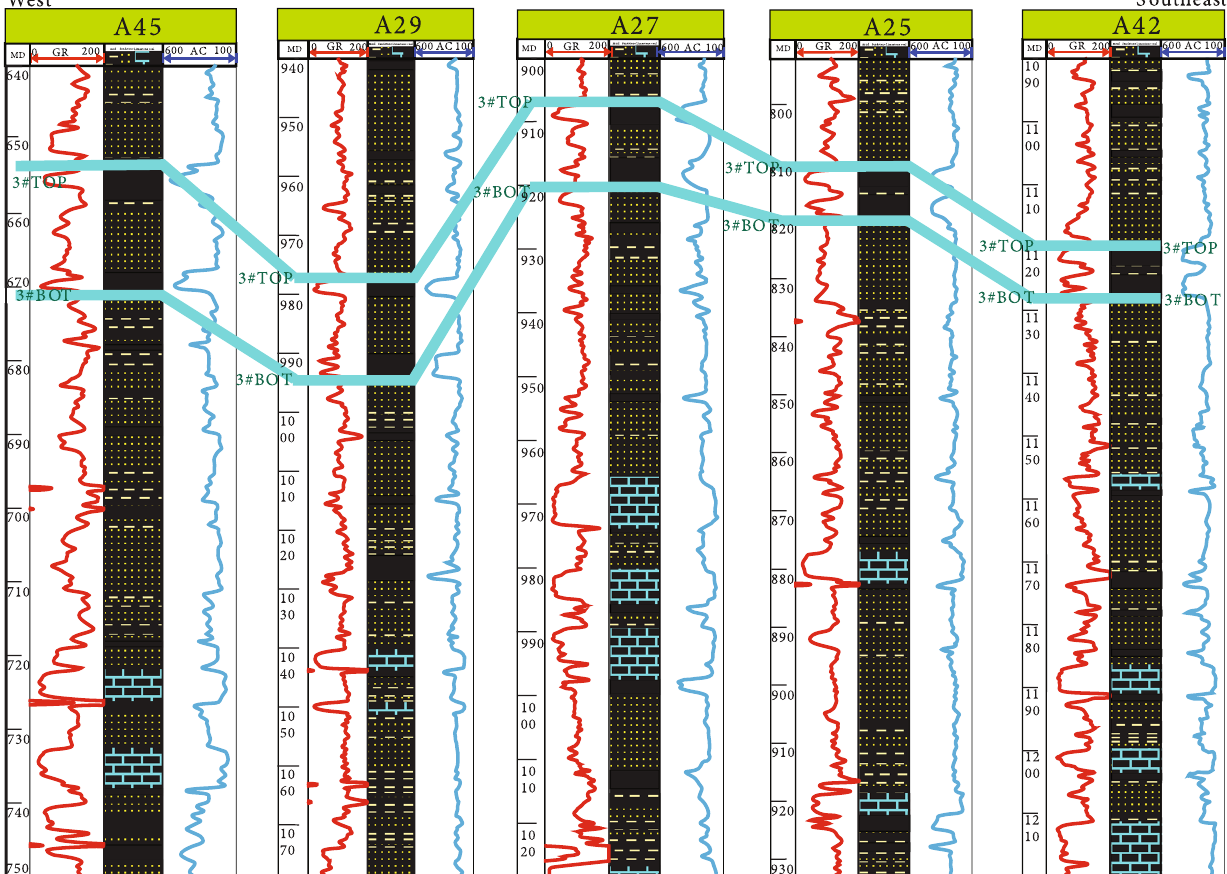
Figure 3: The pro fi le of well-connection in the Anze Block (well A45, A29, A27, A25, and A42, left to